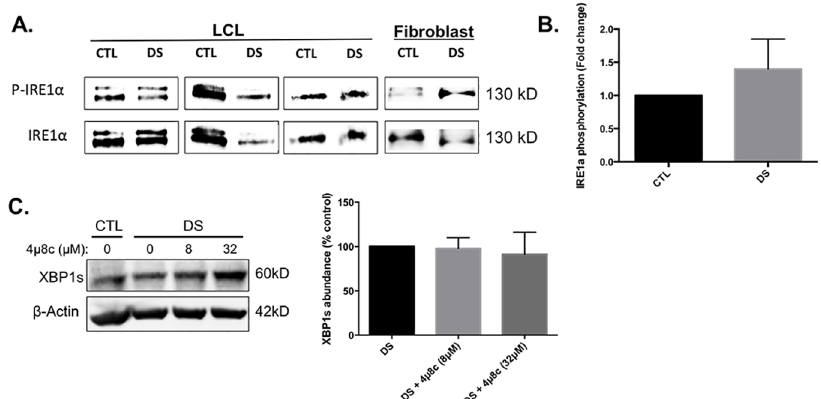
of IRE1 α phosphorylation (A). These data show that LCLs did not displaya clear DS-mediated phenotype, whilethe fibroblastsshoweda DS-mediated increasein phosphorylation (B). Inhibitionof the IRE1 α endonuclease domainwith 4 μ 8c did not significantly decreaseXBP1s abundance in DS fibroblasts (C). Western blots were conductedin triplicate and the images are representative of these replications.